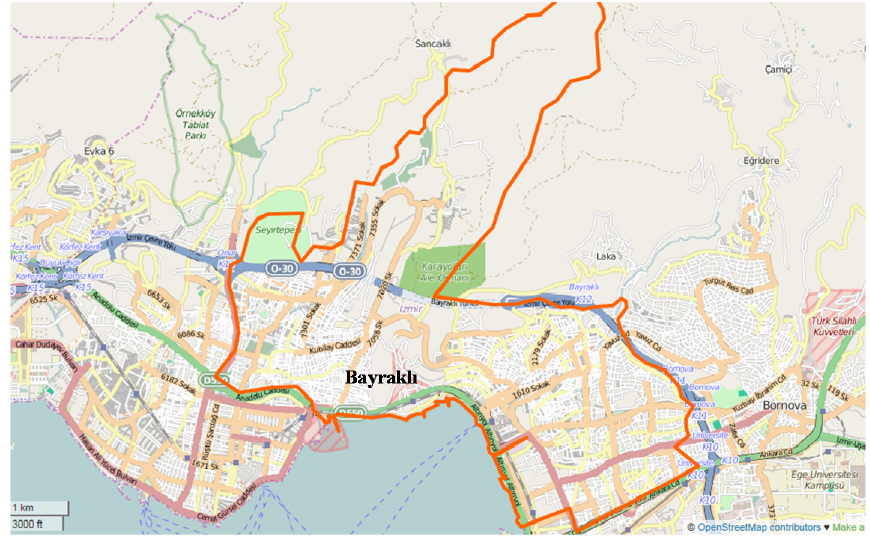
Figure 1. The Map of Izmir showing the location of Bayrakl ı District.